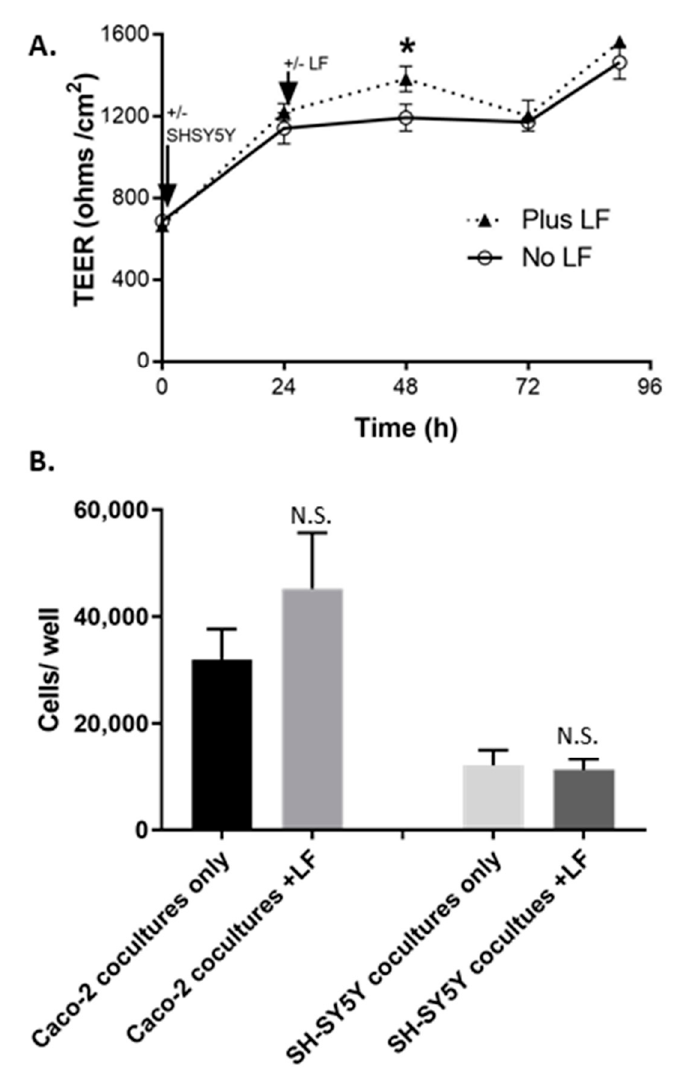
Figure 3. Effects of the apical addition of Lactobacillus fermentum (LF) on the co-culture model in terms of ( A ) TEER and ( B ) cellometry of the two cell lines. Setting-up the model followed Scheme 2, except in place of juice was added 1.0 × 10 7 colony-forming units of the lactobacillus or complete media without the bacillus per well. A three-day series of daily TEER measurements ensued as in Figure 1. At the end of three days, the cells were harvested from the inserts ( Caco-2Bbe1 s) and from underneath in the wells ( SH-SY5Y s) and counted by cellometry as in Figure 2. Points represent mean values ± SEM ( n = 4–5 experiments per condition). The asterisk indicates p < 0.05 by two- tailed analysis.